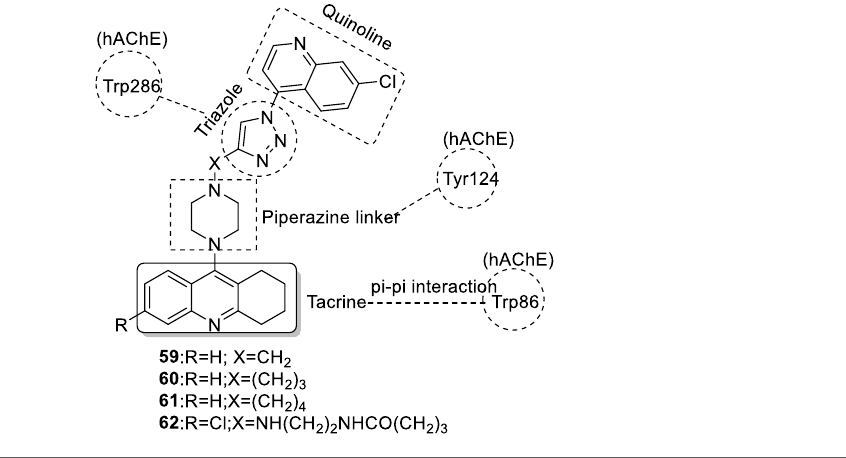
Figure 19. Chemical structure of tacrine – 1,2,3-triazole – quinoline trihybrids.